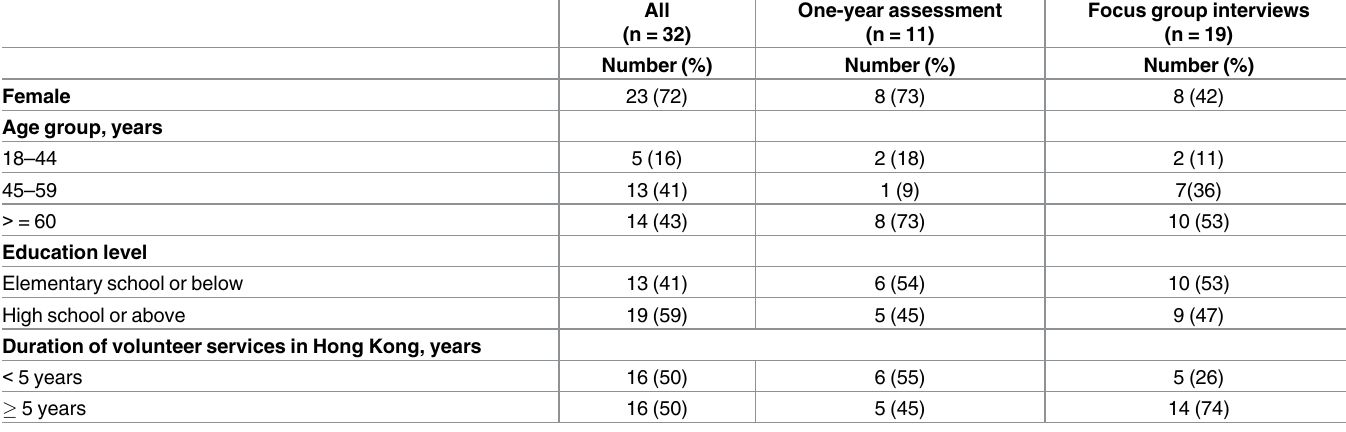
Table 4. Demographic characteristics of all trainees, those who completed one-year assessment,and those who joined the focus group interviews.